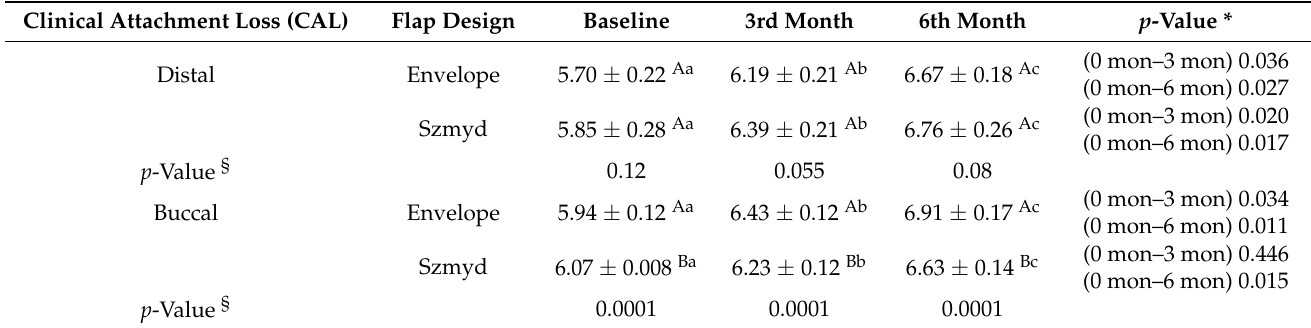
Table 5. Comparison of clinical attachment loss (mm) around second molars among study groups.